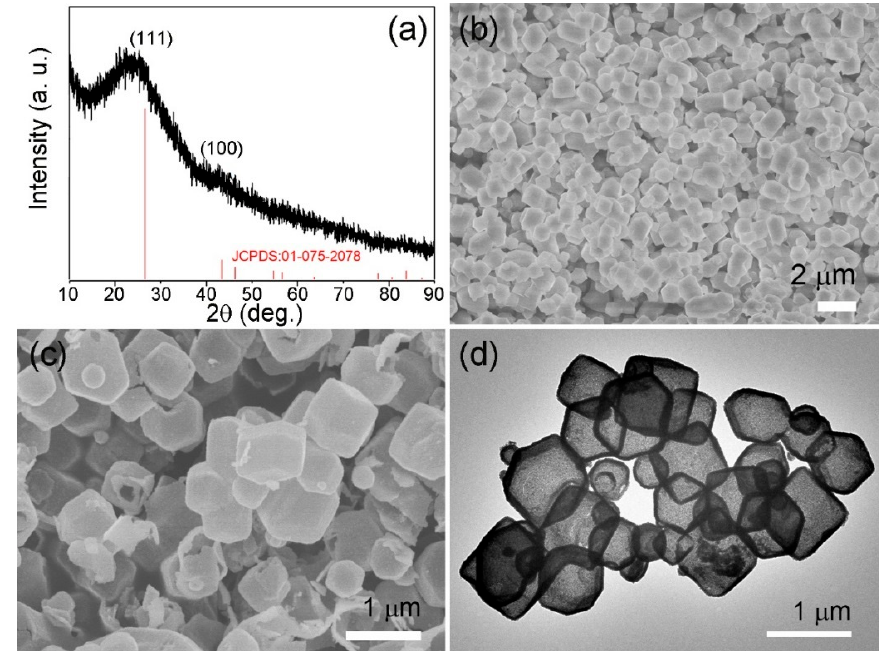
Figure 2. ( a ) X-ray diffraction (XRD) pattern of the ZHC; ( b , c ) scanning electron microscopy (SEM) image of ZIF-8 and ZHC; ( d ) transmission electron microscopy (TEM) image of the obtained ZHC.